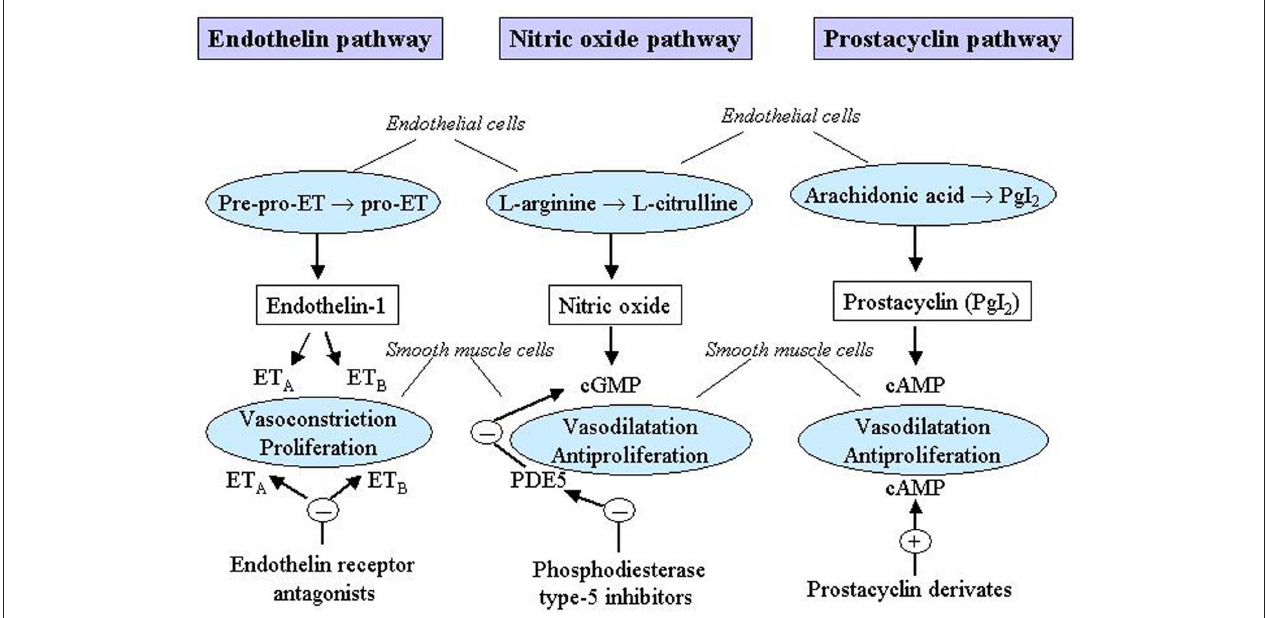
FIGure 1 | Mechanisms which trigger pulmonary arterial hypertension (PAH) as targets for pharmacological treatments. cAMP, cyclic adenosine monophosphate; cGMP, cyclic guanosine monophosphate; ET, endothelin; ET